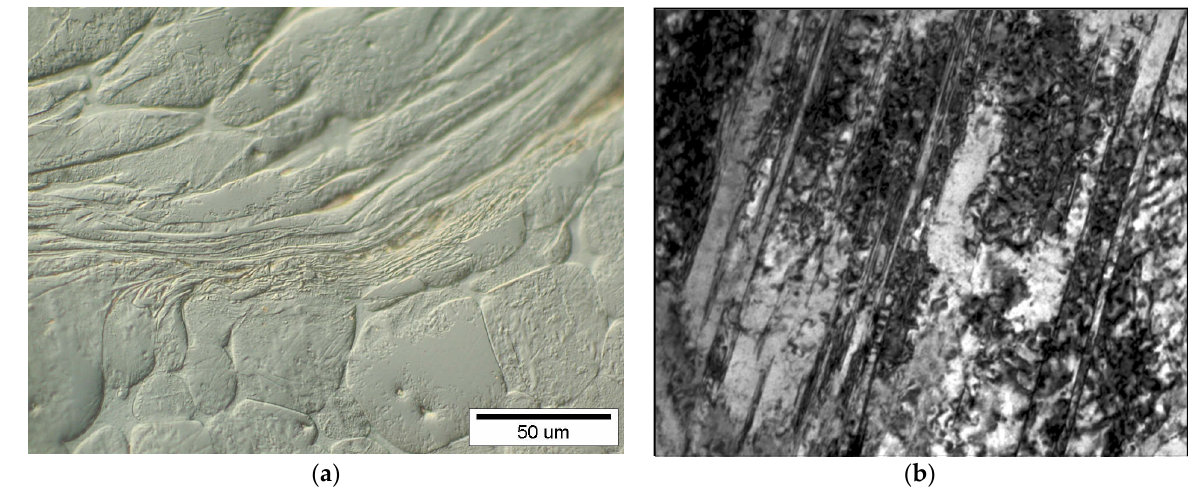
Figure 1. The example of ASB in the tungsten heavy alloys penetrator: ( a ) metallographic photo, ( b ) transmission electron micrograph (TEM) area × 40.000.